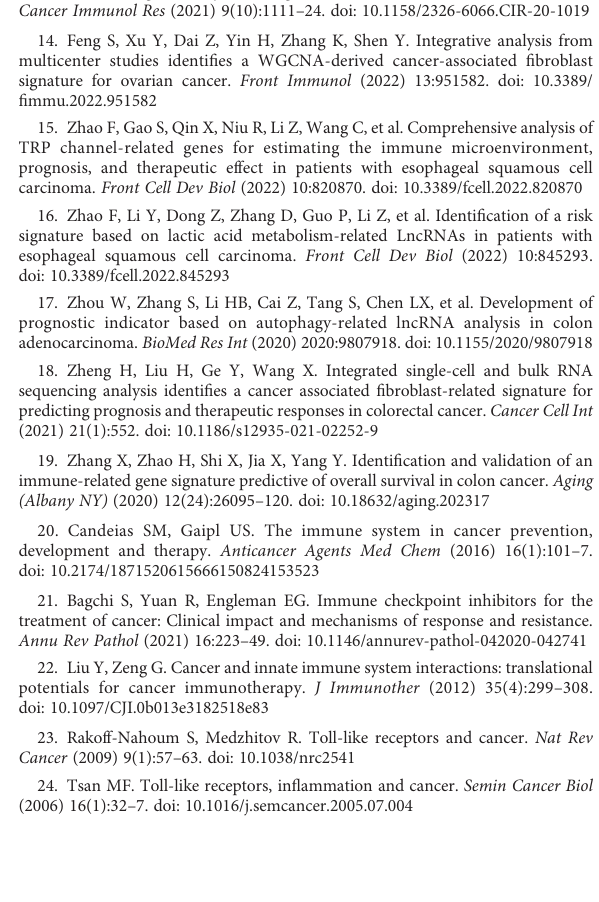
SUPPLEMENTARY FIGURE 2 Comparison of Immune cell content of different molecular subtypes in different algorithm.